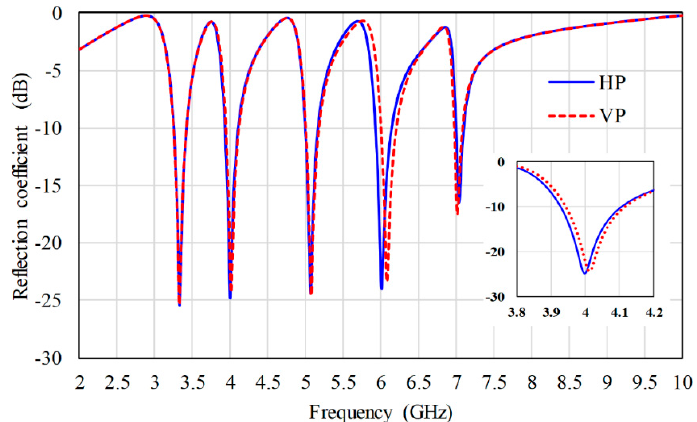
Figure 6. Vertically (VP) and horizontally (HP) polarized S 11 of the proposed tag with state “1010101010”.